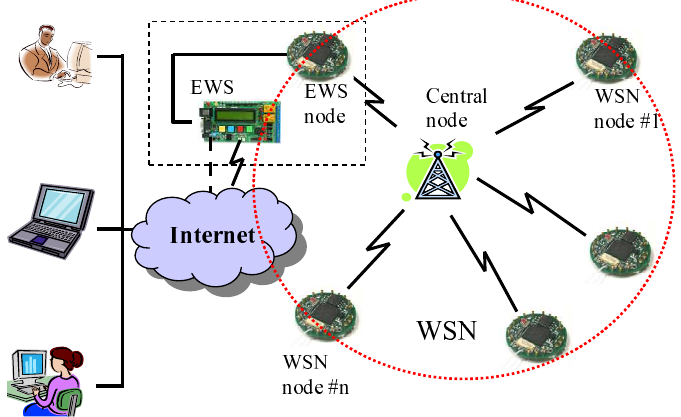
Figure 2. Embedded web server (EWS) for wireless sensor networks